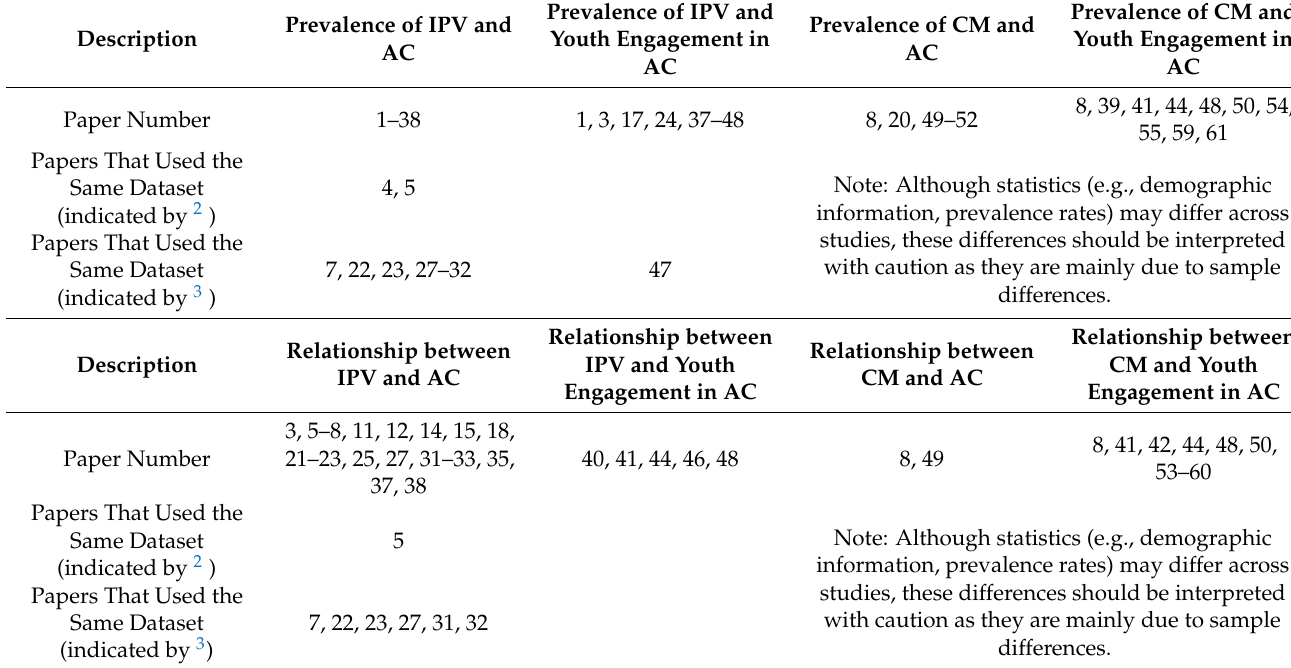
Table 2. Overview of Studies Included in the Scoping Review.